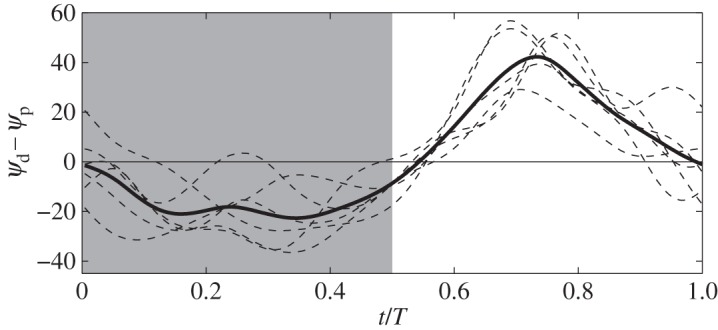
Wing twist as measured using the difference between two chord angles.